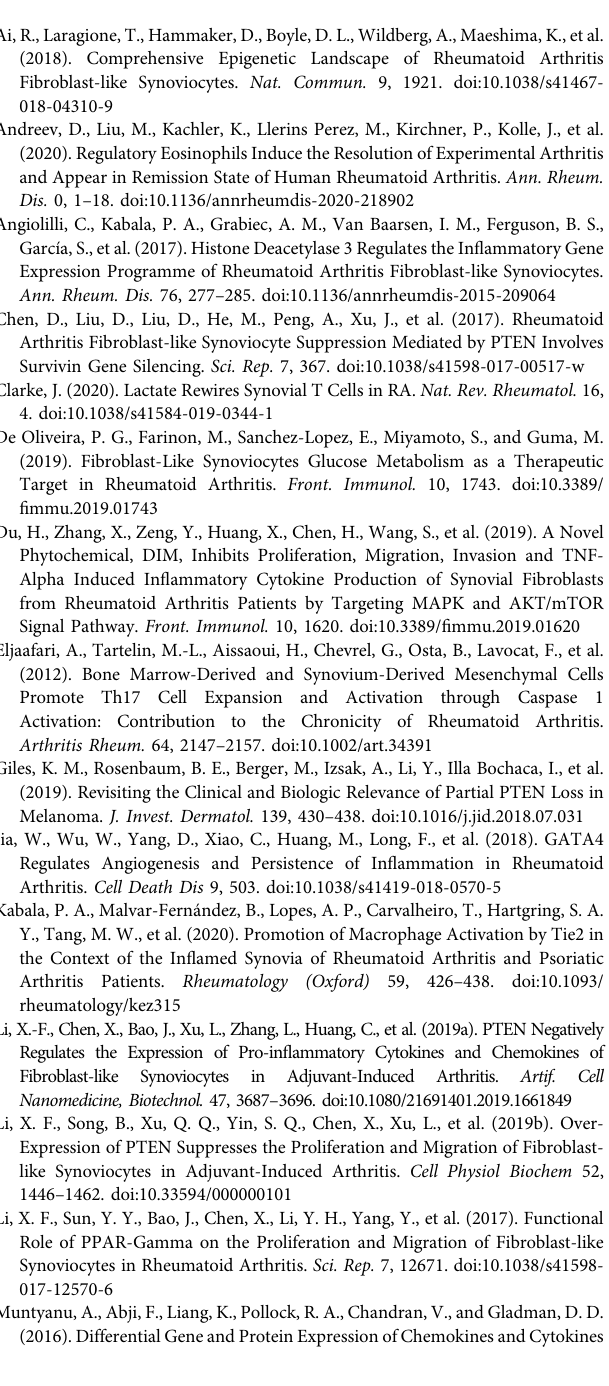
Supplementary Figure 1 | Inhibition of methylation alleviates in fl ammation in the synovium of rats with AIA. Rats were intraperitoneally injected with 5-azadC (0.7 mg/kg). (A) PTEN, TNF- α , and DNMT1 protein levels in synovial tissue detected by western blotting. (B) TNF- α and PTEN mRNA levels in synovial tissue detected by qRT-PCR. (C, D) IL-1 β , IL-6, and IL-17A mRNA (C) and